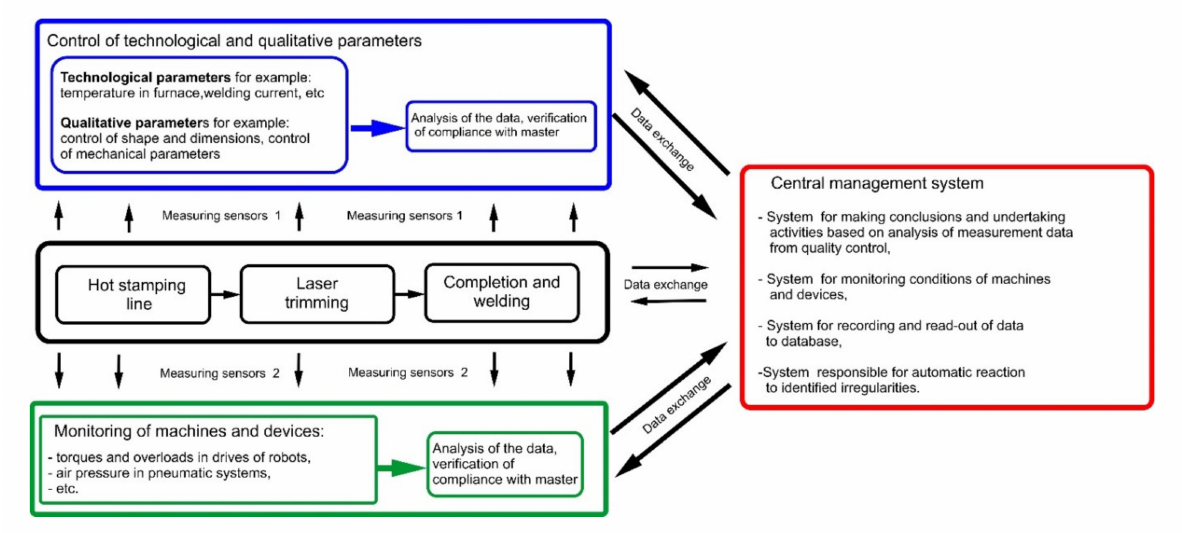
Figure 2. Scheme of exchanging information in the production line, compliant with concept of Industry